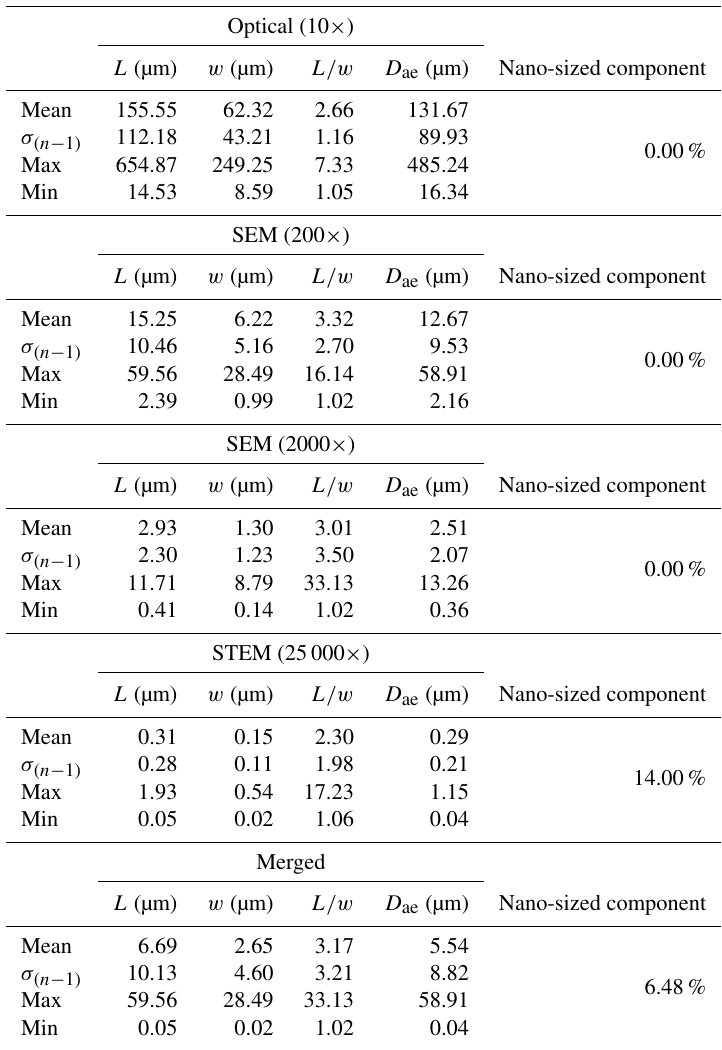
Table 4. Summary of the descriptive statistics of glaucophane particles using different microscopy imaging techniques ( n = 100 each, except for the merged dataset, where n = 216). The nano-sized ( < 100nm) component is determined using D ae as